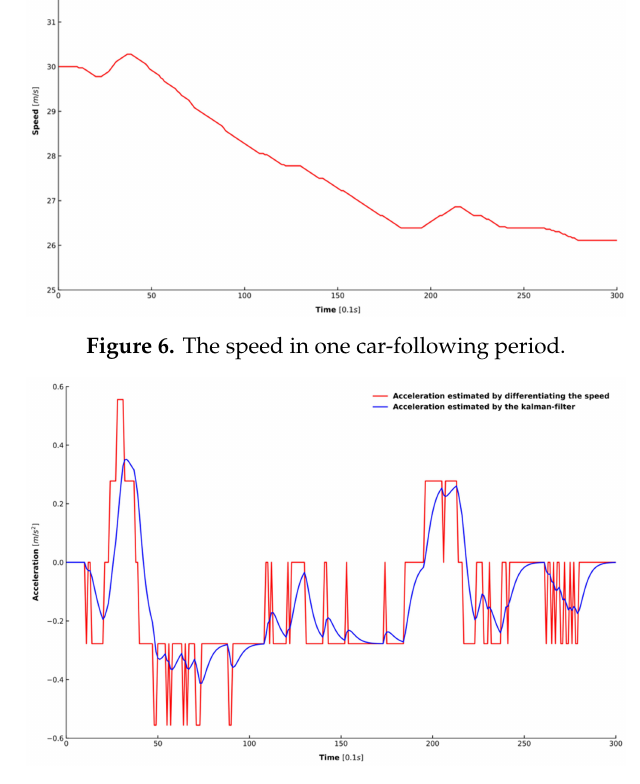
Figure 7. The comparison of di ff erent methods for estimating acceleration from the raw